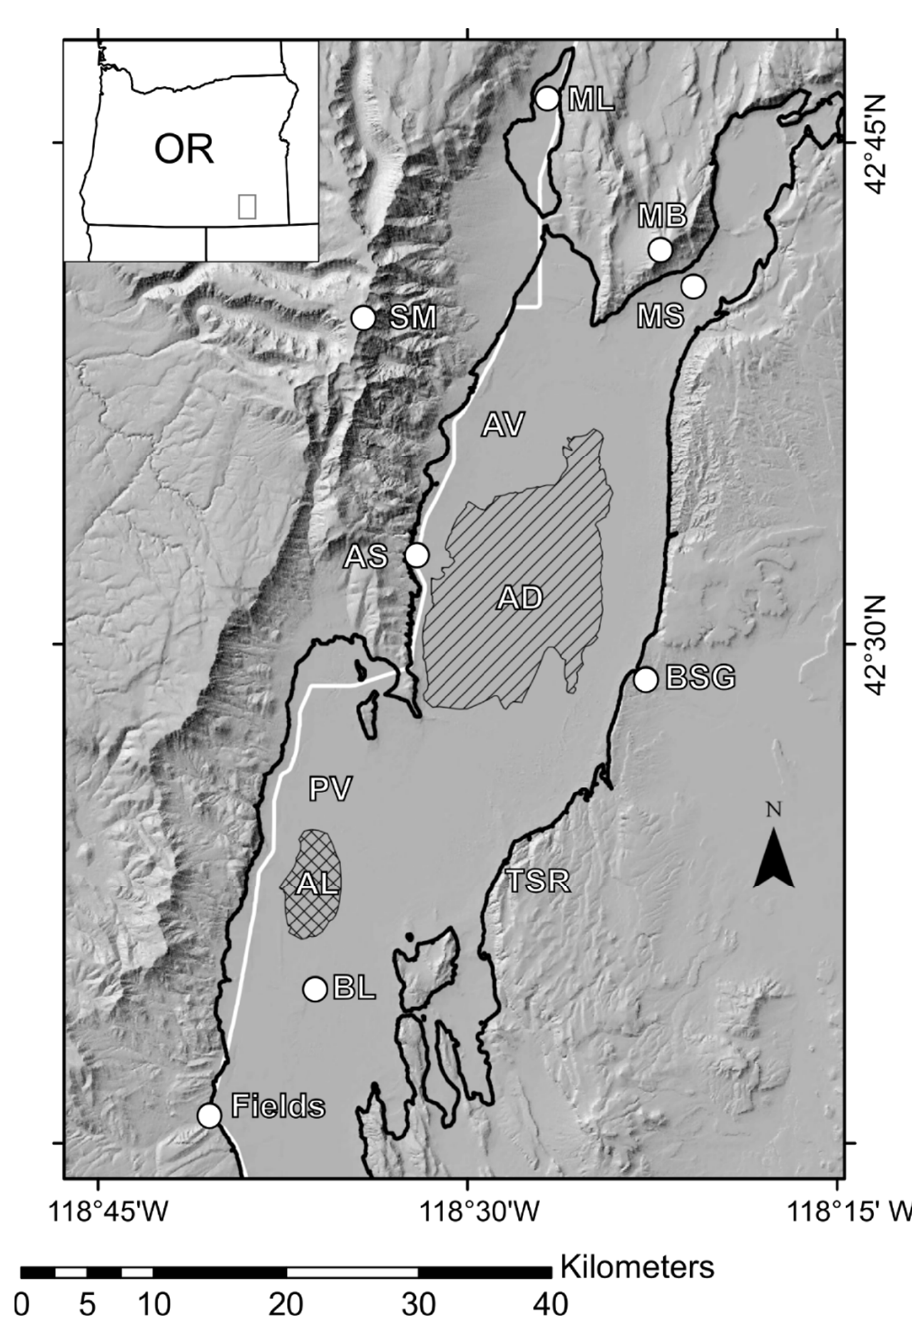
Figure 1. Location map of Mickey Springs (MS) in relation to Alvord Valley (AV) and Borax Lake in the Pueblo Valley (PV) in southeastern Oregon. High ‐ stand elevation of pluvial Lake Alvord is outlined in black at 1292 m, before outburst flood at Big Sand Gap (BSG) in the Tule Springs Rim (TSR) lowered the lake level to 1280 m. Fields ‐ Denio Road represented by the white line. Alvord Hot Springs (AS), Steens Mountain (SM), Mickey Butte (MB), dry lakebed of Alvord Desert (AD, 1221 m), extent of seasonally wet Alvord Lake (AL, 1227 m), Mann Lake (ML), community of Fields, Oregon, and bath house trench [8] located at Alvord Hot Springs.